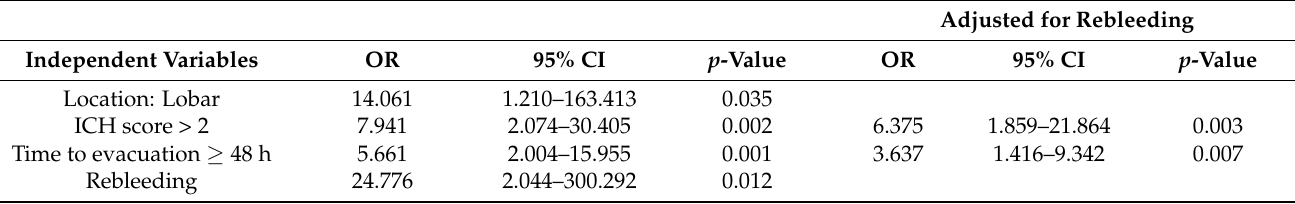
Table 3. Multivariate analysis of poor outcome 3 months after